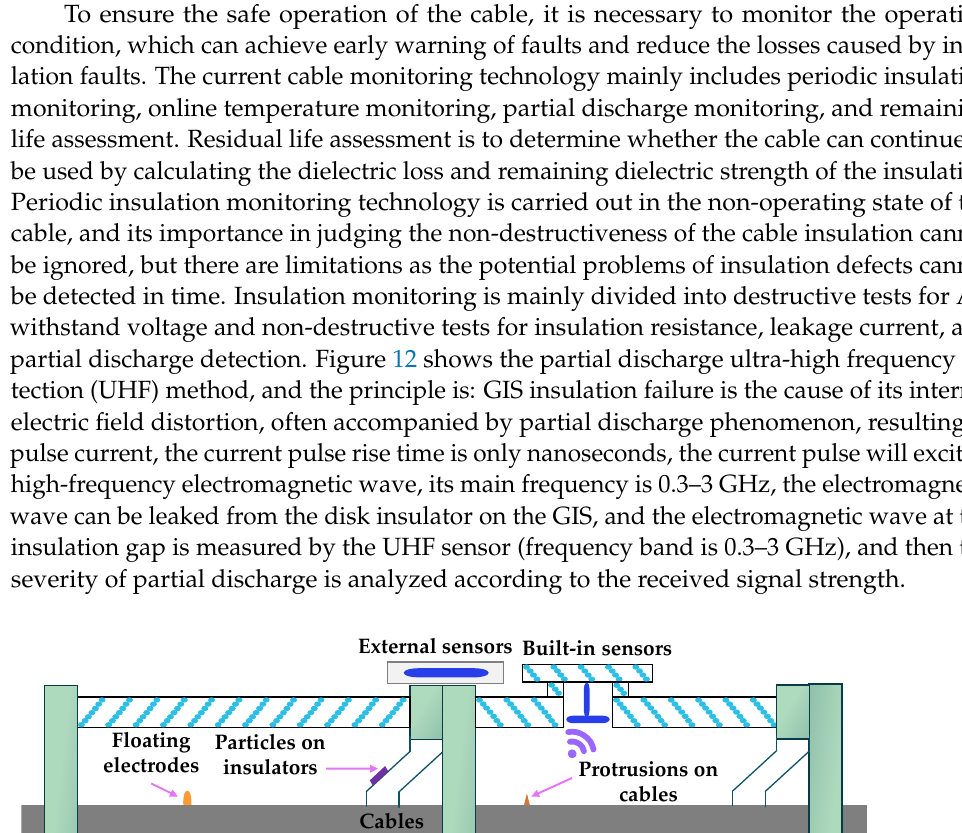
Table 1. Cable online monitoring technology features. Online Monitoring Methods Measurement Parameters